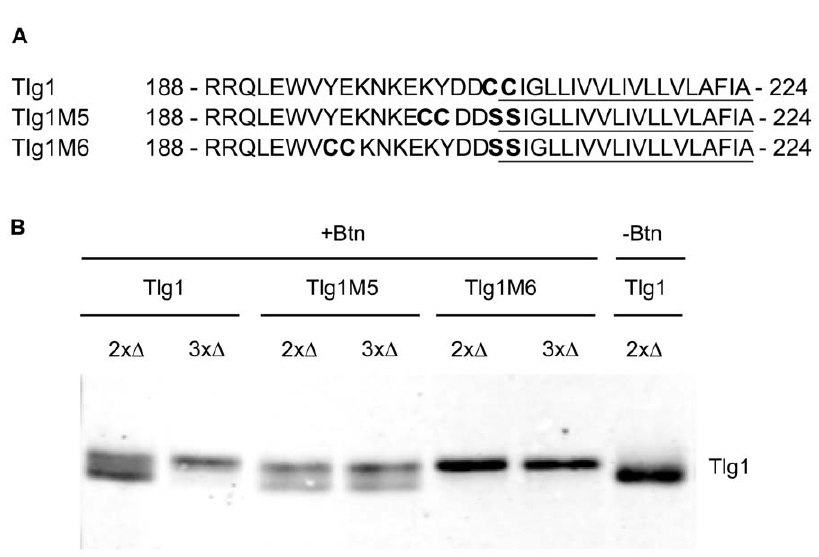
Figure 7. Topological requirements for Tlg1 palmitoylation. A . Sequences of the relevant regions from Tlg1, Tlg1M5 and Tlg1M6. The TMD region is underlined. B . Western blot analysis of myc-tagged Tlg1, Tlg1M5 and Tlg1M6 in bsd2 D tul1 D (2x D ) or bsd2 D tul1 D swf1 D (3x D ) strains. Samples were treated with Biotin-BMCC, which biotinylates unpalmitoylated cysteines, resulting in slower migration. Blot was probed using anti c-myc antibodies. A non-biotinylated control sample of wt Tlg1 was included for comparison.